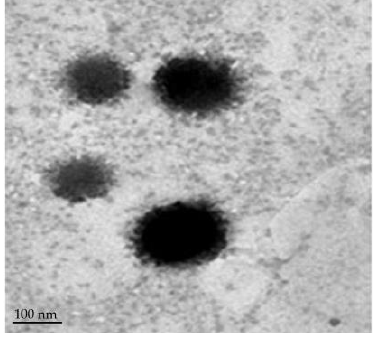
Figure 4. Transmission electron imaging of optimized SMV-BS.